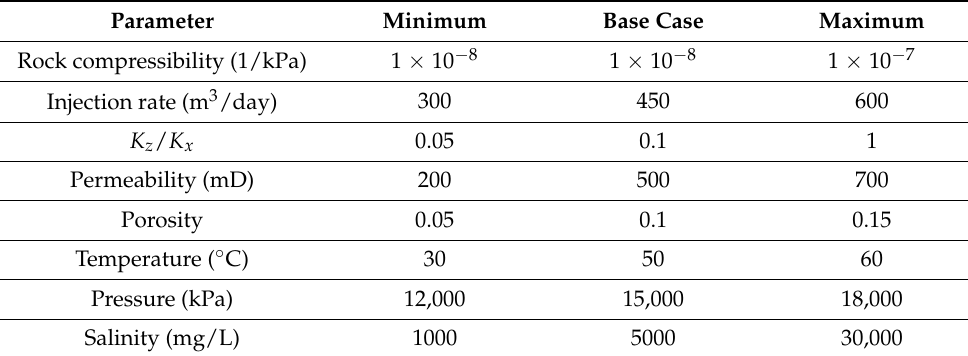
Figure 4. Relative permeability ( a ) and capillary pressure ( b ) curves for the Arbuckle aquifer [27]. Table 1. Properties used in the numerical simulation.